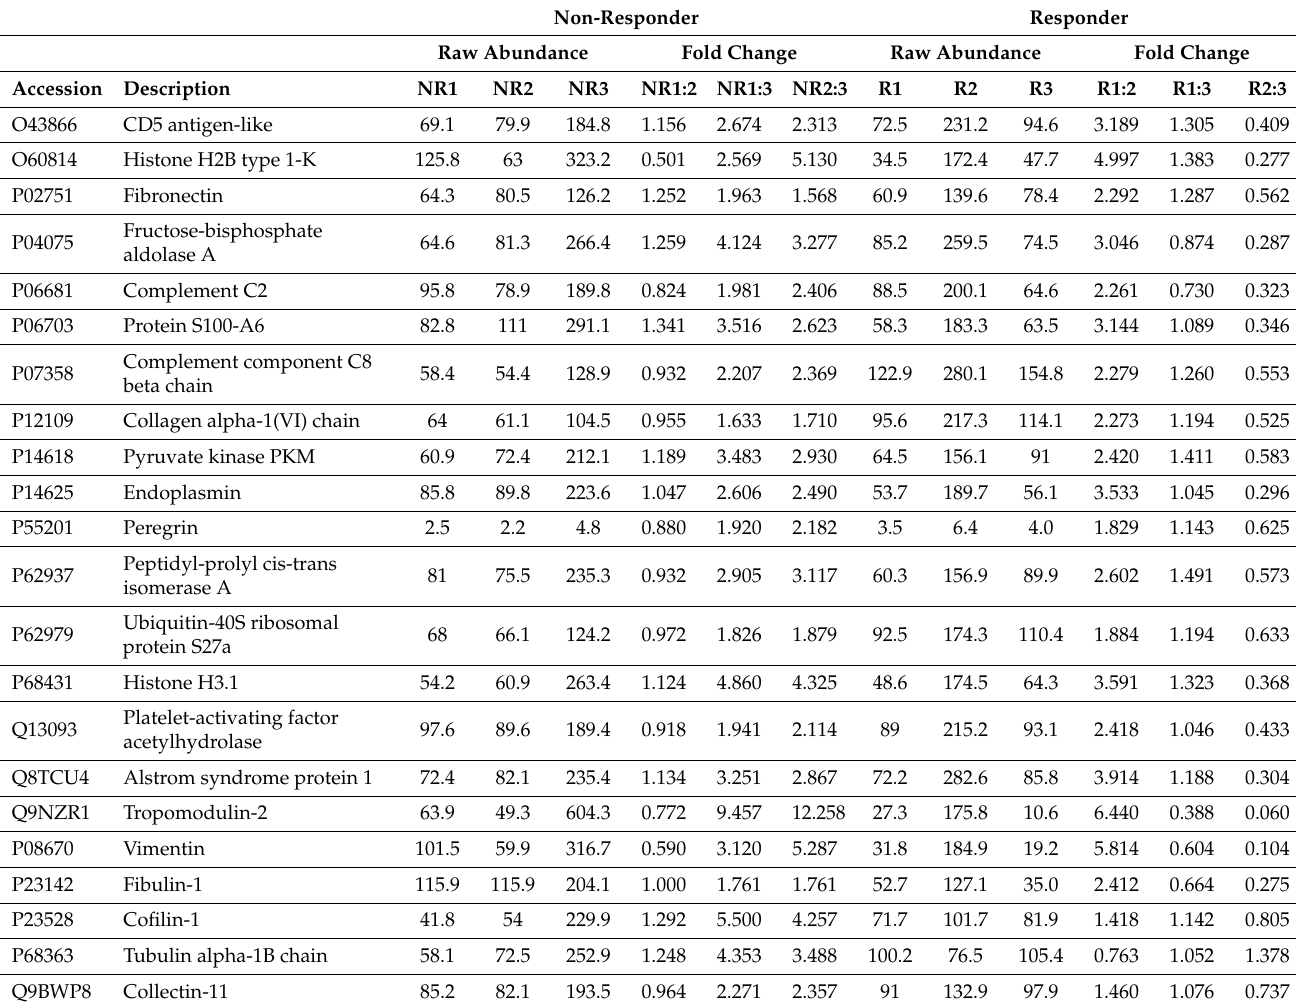
Table 5. Extracellular vesical associated proteins that are increased in abundance in the non-responder. Non-Responder Responder Raw Abundance Fold Change Raw Abundance Fold